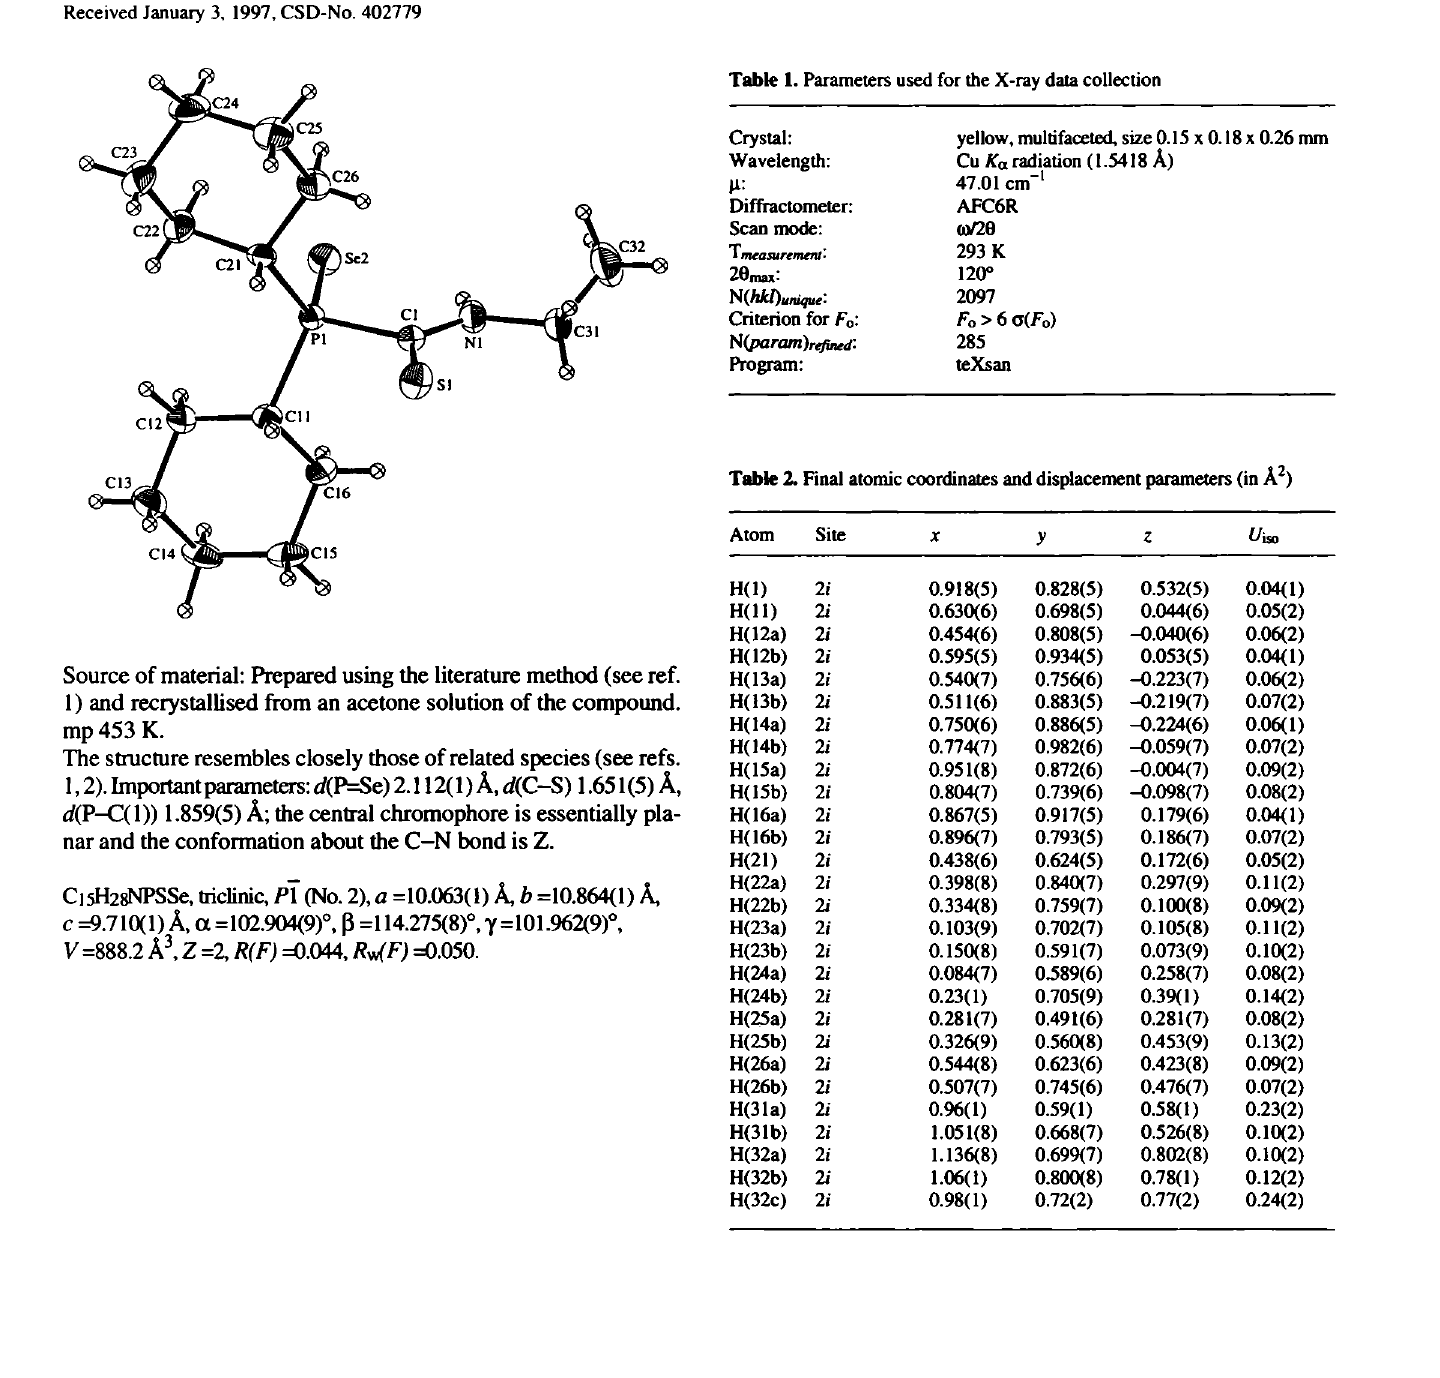
Table 1. Parameters used for the X-ray data collection